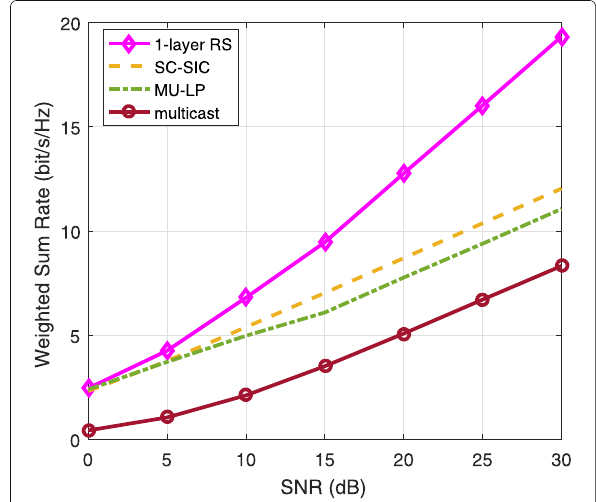
Fig. 20 Weighted sum rate versus SNR comparison of different strategies for overloaded ten-user deployment with perfect CSIT, = σ 2 = ... = σ 2 = 1, N = 2, SNR = 30 dB, r σ 2 t 1 2 10 0.1,0.1,0.1,0.1]